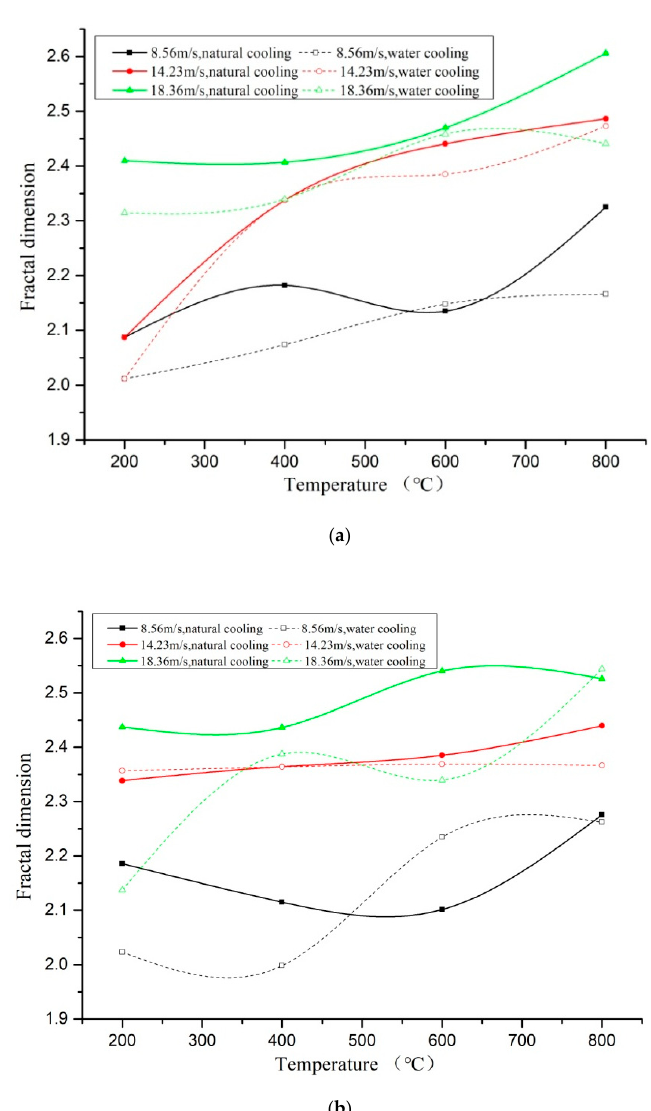
Figure 13. Comparison of the fractal dimensions under different cooling methods. ( a ) Comparison of the fractal dimensions by different cooling methods, slow heating; ( b ) Comparison of the fractal dimensions by different cooling methods, rapid